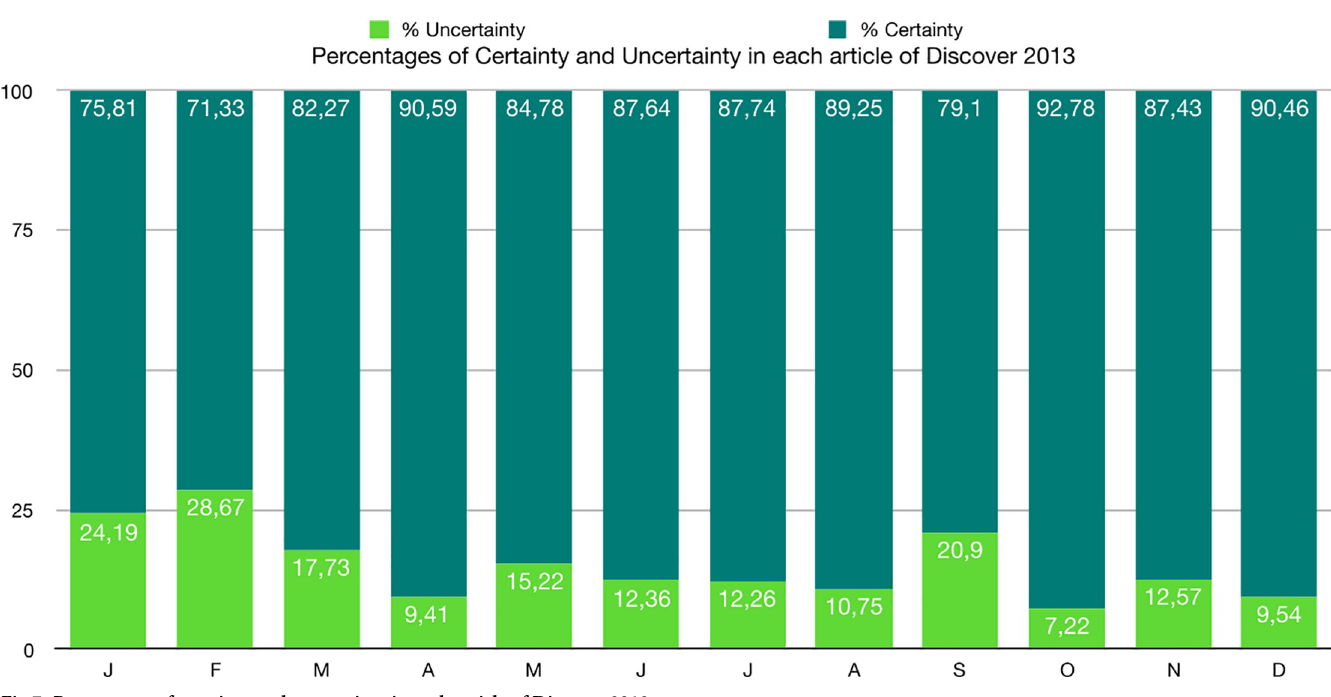
Fig 7. Percentages of certainty and uncertainty in each article of Discover 2013.